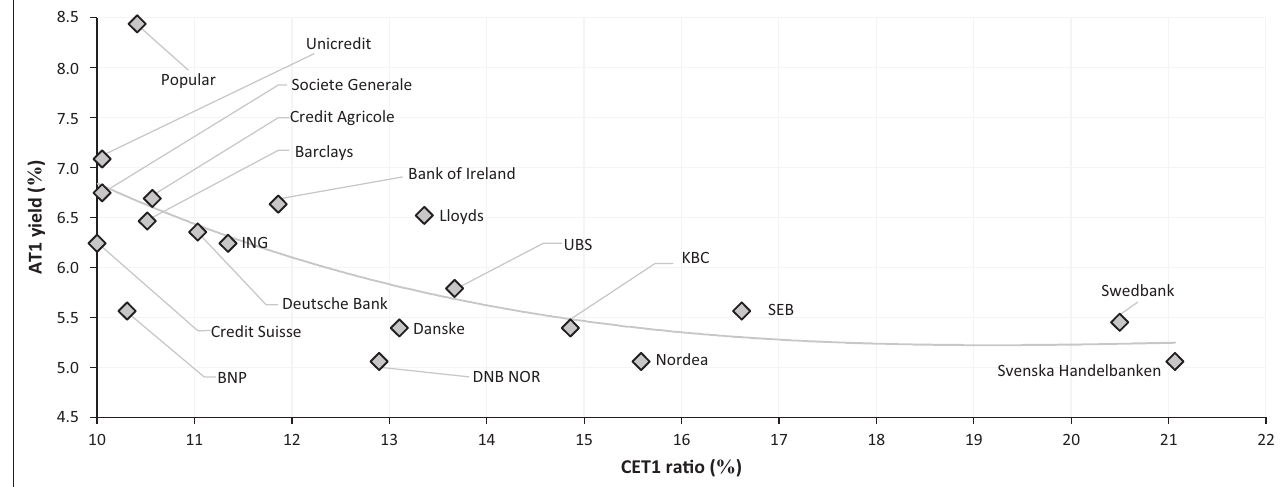
FIGURE 5: Contingent convertible common equity tier 1 ratios and associated additional tier 1